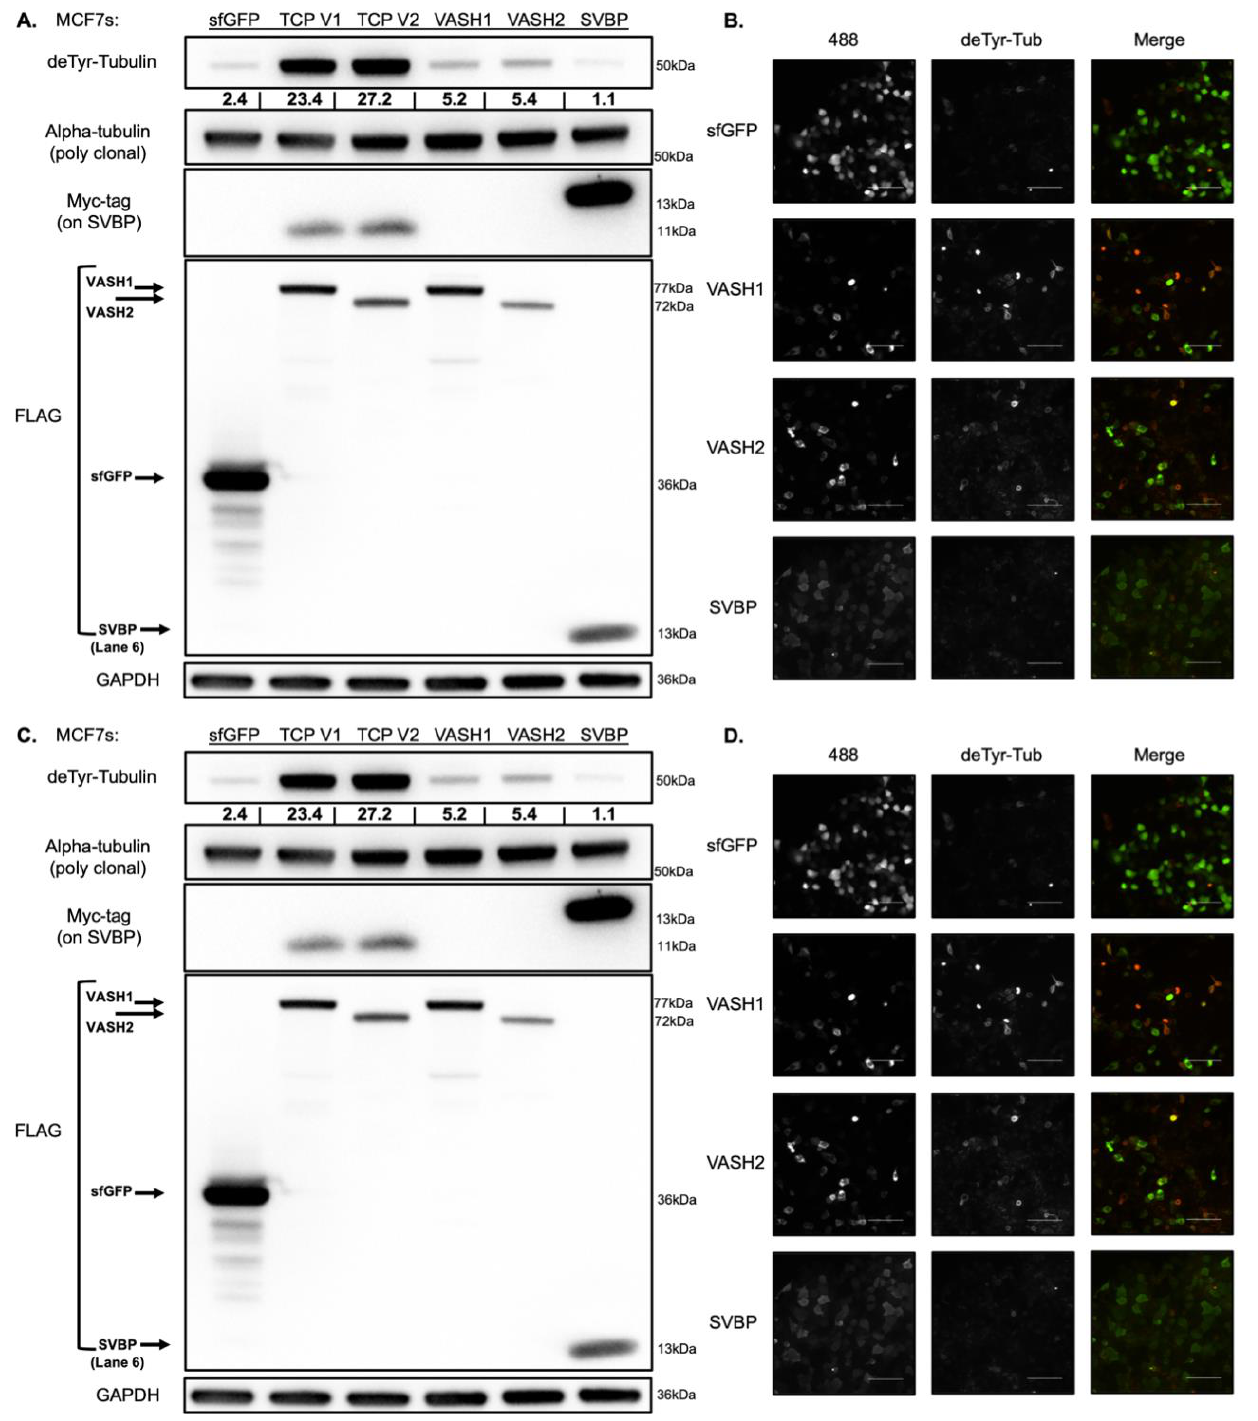
Figure 2. TCP- VASH1 and TCP- VASH2 plasmids lead to the maximal deTyr-Tub increase in MCF10A human mammary epithelial cells and MCF7 breast cancer cells. ( A ) MCF10A cells were plated and transfected with a CAG plasmid containing TCP- VASH1 , TCP- VASH2 , VASH1 - sfGFP alone, VASH2 - sfGFP alone, or SVBP alone for 24 h prior to being lysed with RIPA buffer. The TCP- VASH1 or TCP- VASH2 constructs generate the highest level of deTyr-Tub after 24 h. SVBP did not increase deTyr-Tub compared to sfGFP control, while VASH1 and VASH2 alone generated an intermediate increase in deTyr-Tub. Probing with the FLAG-tag antibody reveals the presence of sfGFP , vasohibin, or SVBP alone. The expression of SVBP can be visualized in both the SVBP alone and IRES-expressed TCP constructs given the myc-tag on SVBP . ( B ) Immunofluorescence staining for